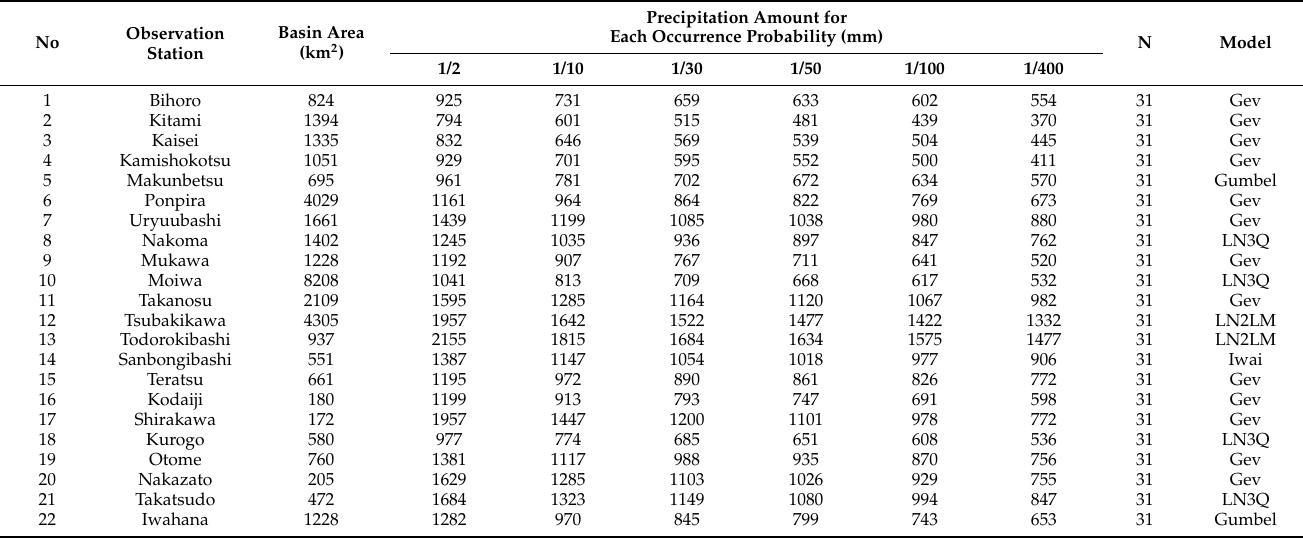
Table 1. The calculation result of precipitation amount for each occurrence